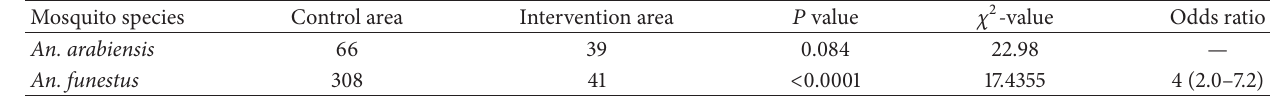
Table 2: Indoor resting patterns for blood fed Anopheles mosquitoes.